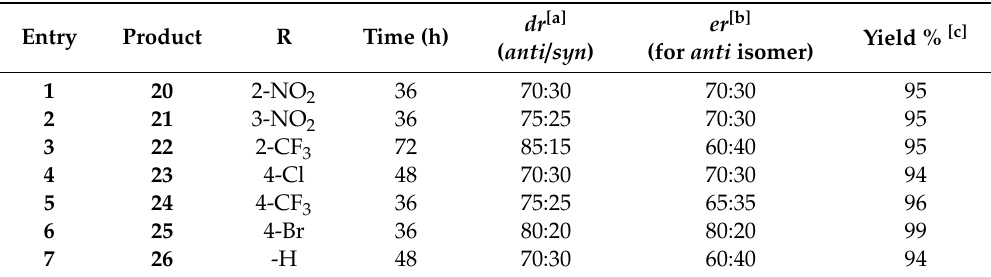
catalyzed by ( S ) -5 .